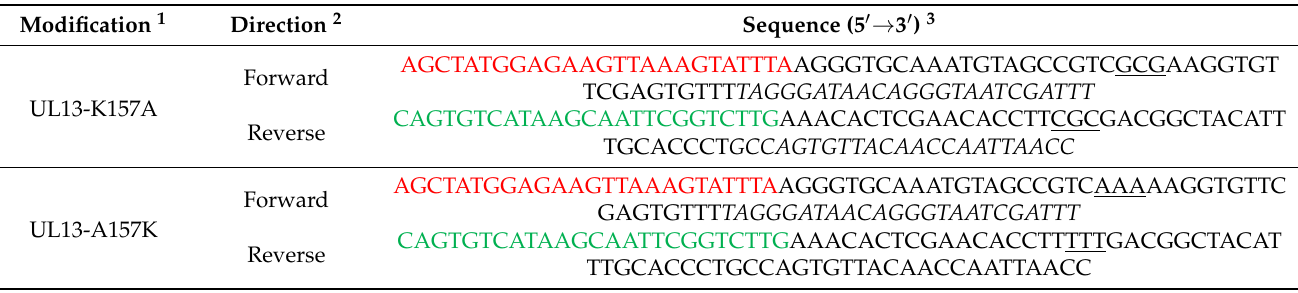
Table 1. Primers used for the generation of recombinant 301B/1.